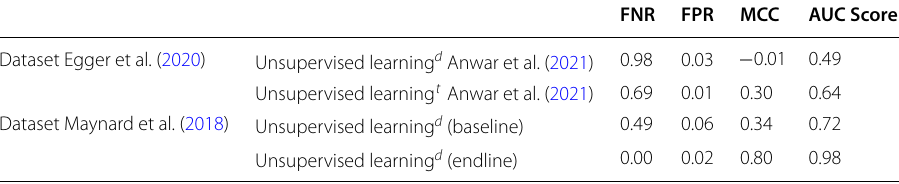
Table 5 Comparison of related one-class SVM anomaly detection results on 2 IEC 104 protocol